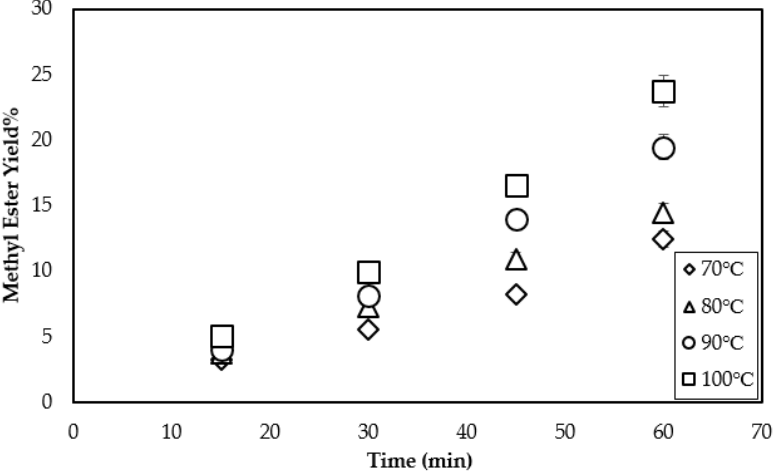
Figure 6. Effect of reaction temperature on the methyl ester yield (triolein flow rate of 6.0 mL/min and 5 wt% CaO).